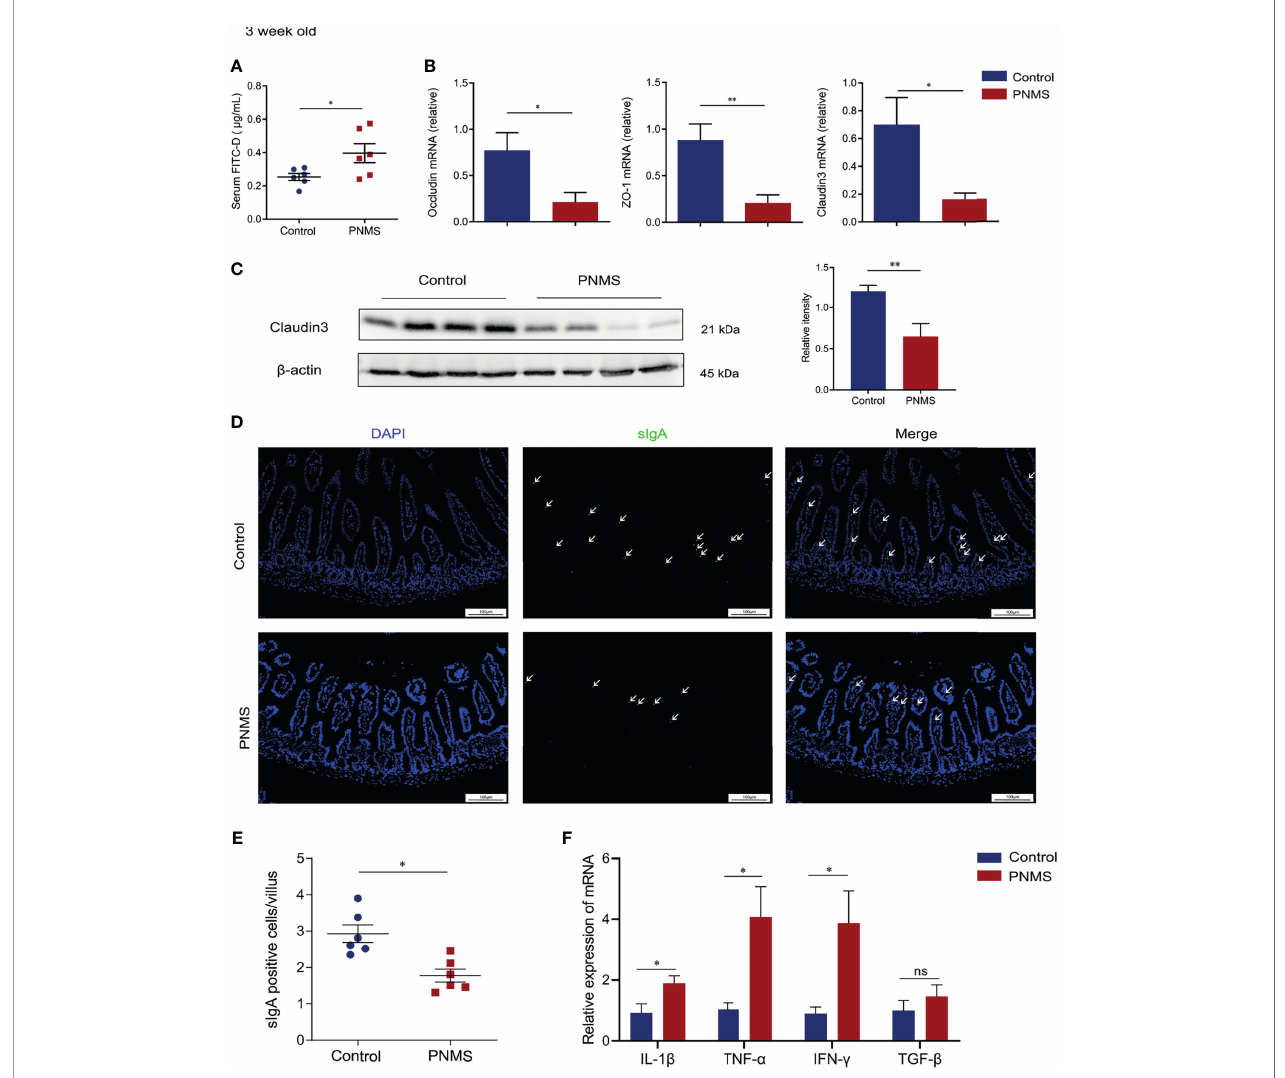
FIGURE 3 | Prenatal maternal stress impaired the intestinal barrier and induced colonic mucosal low-grade in fl ammation in 3-week-old offspring. (A) Intestinal permeability was measured through fl uorescein isothiocyanate – dextran (FITC-D) assay. (B) Quanti fi cation of the relative mRNA expression levels of ZO-1, occludin, and claudin 3. (C) Western blot bands and relative quanti fi cation of claudin 3 in the colon. (D) Immuno fl uorescence staining of sIgA ( green ) and nuclear staining with DAPI ( blue ) were visualized via a fl uorescent microscope. (E) Number of sIgA-positive cells per intestinal villus. (F) mRNA levels of the in fl ammatory cytokines in the colon. PNMS , prenatal maternal stress; sIgA , secretory immunoglobulin (A) Scale bar , 100 m m. Magni fi cation, ×200. * p < 0.05, ** p < 0.01, ns p > 0.05. PNMS ( n = 6) vs . control ( n =